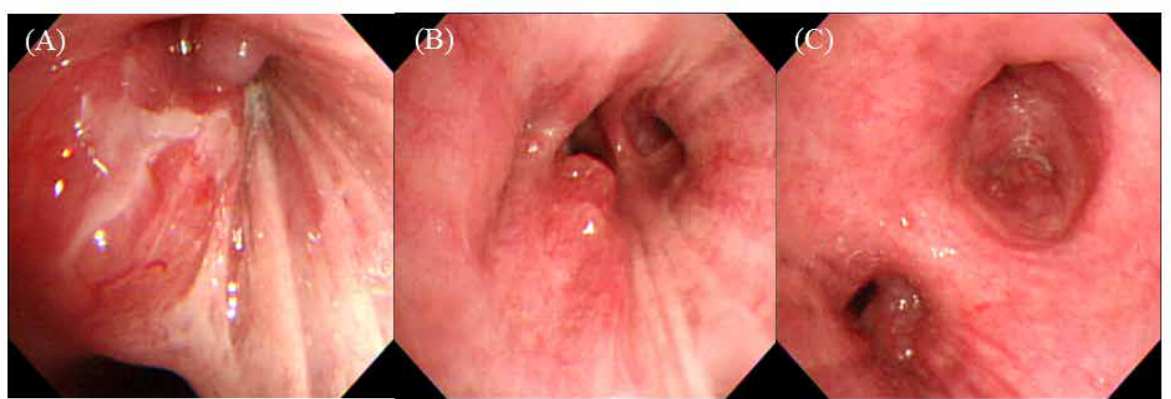
Figure 2: (A) Bronchoscopy revealed exophytic hypervascular nodular projections accompanied by erythematous inflammation with a white mucosal patch in the right upper lobar bronchial orifice. (B) Two endobronchial nodules are also observed at the orifice of right lower lobe. (C) The lumens of the bronchi are extremely narrowed due to multiple variable sized nodules in the orifice of the lingular segment of the left upper lobe and left lower lobar basal